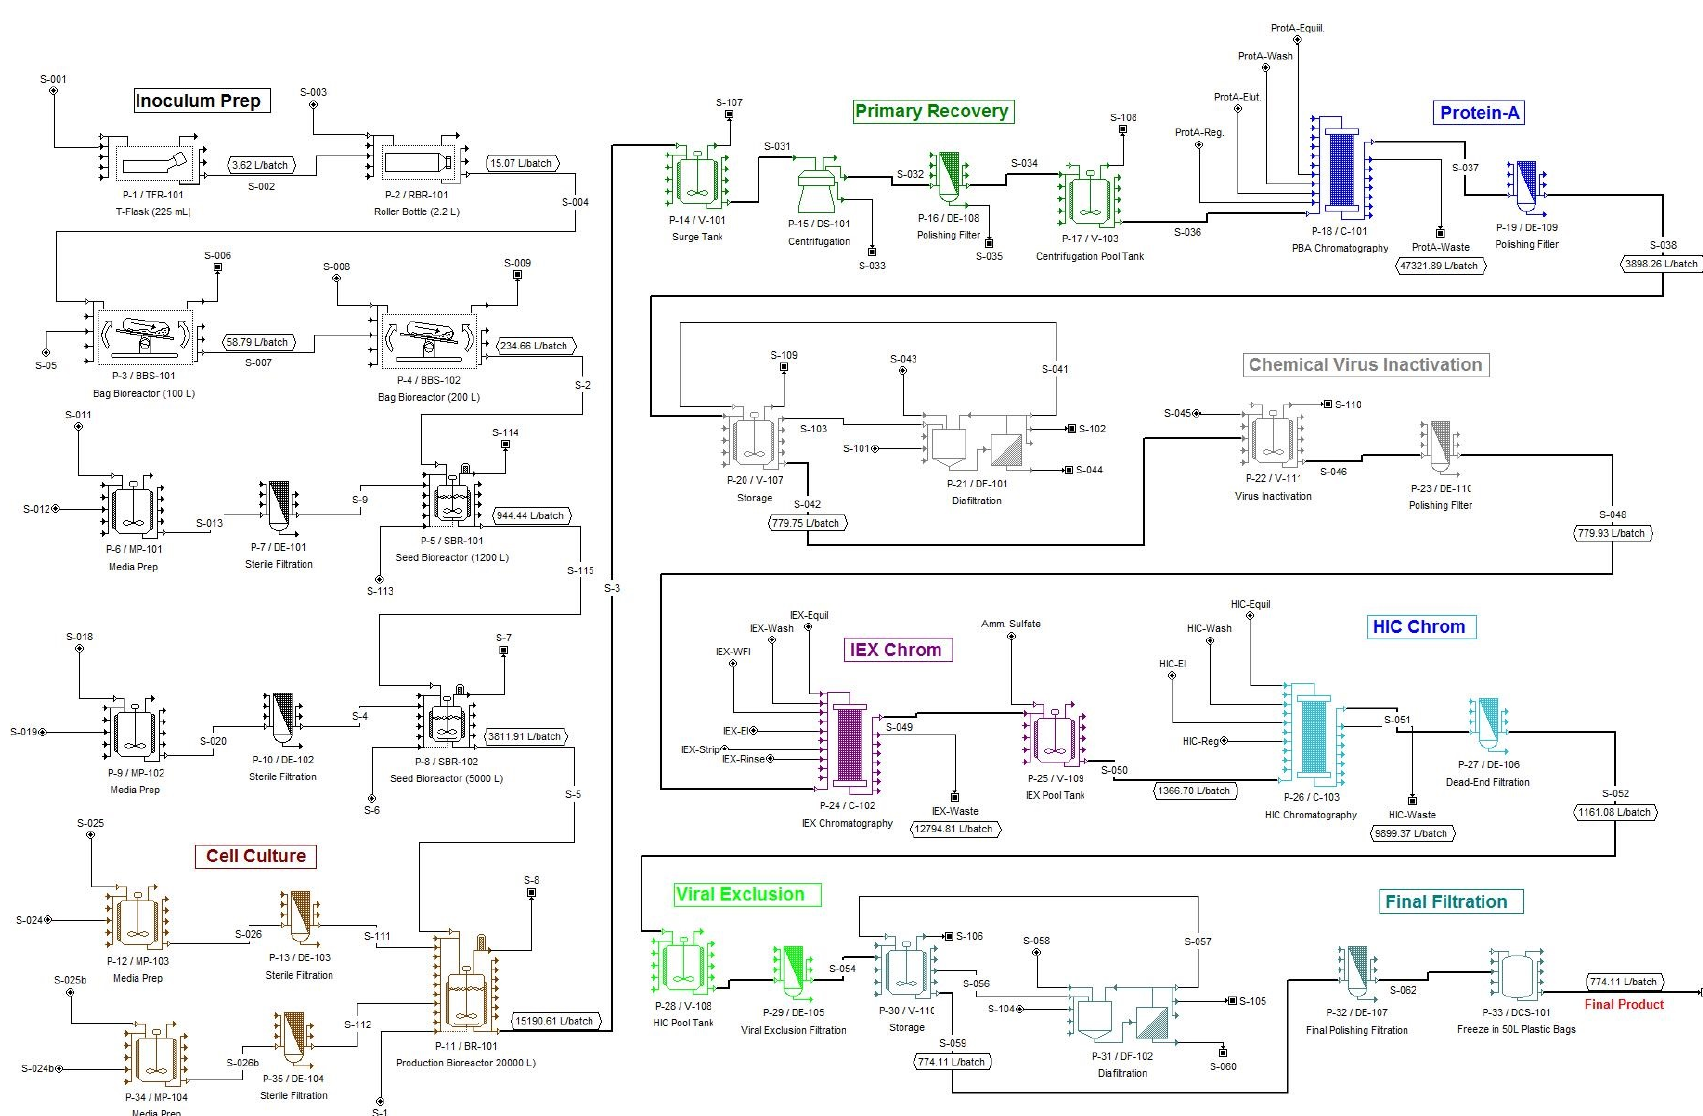
Figure 2. Monoclonal antibody production (MAb)